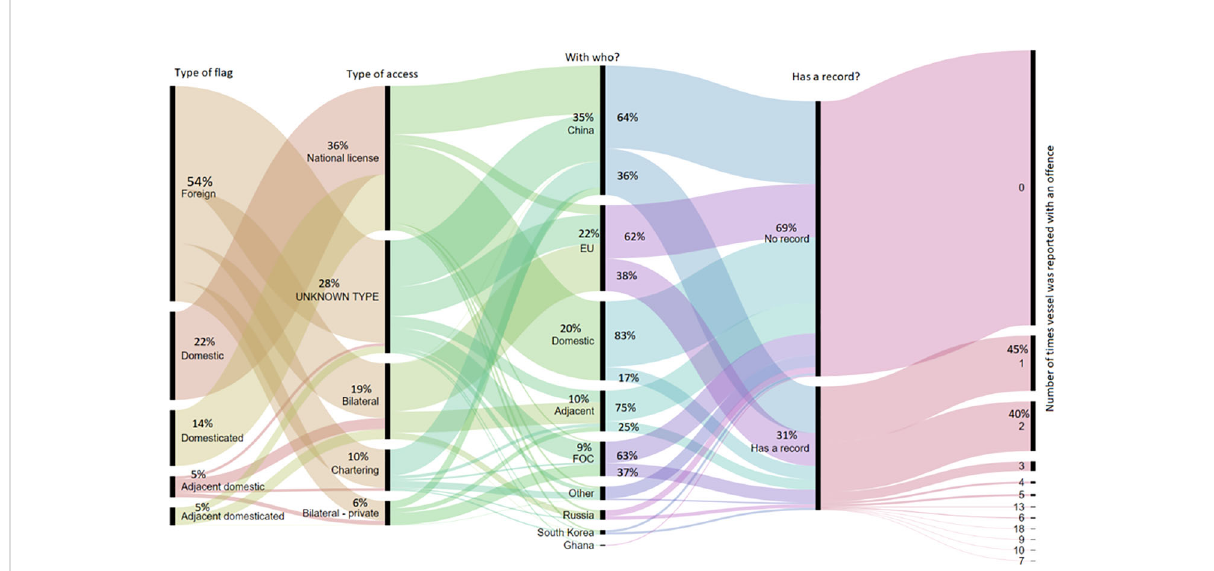
FIGURE 2 Distribution of vessels with a criminal record through nodes of types of fl ags. The fi gure reports domestic, domesticated, foreign, neighboring countries or adjacent domestic, or domesticated to the neighboring countries, i.e., domesticated, type of access, whenever known such as a national license, a bilateral agreement, a chartering agreement, or a bilateral and/or private agreement with a company, ownership of fl ag being typically from, e.g., China, the EU, and South